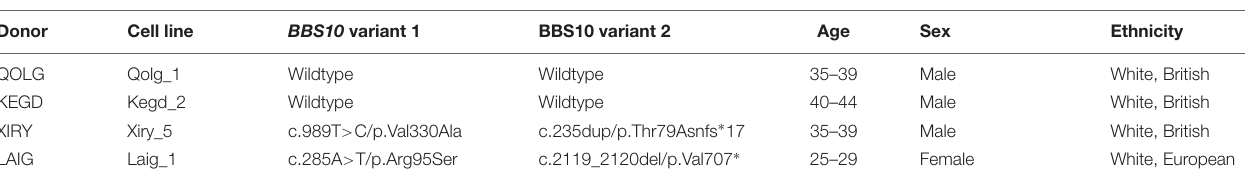
FIGURE 1 | BBS10 variant hiPSCs are pluripotent and can form cilia. (A) Schematic representation of the primary cilium. AX, axoneme; BB, basal body; IFT, intraflagellar transport. BBS1-20 proteins are depicted in their associated complex (BBSome and chaperonin) or by localization to other structures (scheme adapted from Suspitsin and Imyanitov, 2016). (B) Schematics showing BBS10 transcript and protein structure (723AA). Regions exhibiting homology with chaperonin domains are shown in the wildtype protein (scheme adapted from Álvarez-Satta et al., 2017). Variants from two BBS10 mutant lines XIRY (blue) and LAIG (red) are mapped onto protein domains with comparison to control (QOLG or KEGD). (C–E) Cells were immunostained for the pluripotency marker OCT3/4. Control (QOLG) cells and BBS10 mutants (XIRY and LAIG) all had positive staining in the nucleus. Merge with DNA dye Hoechst (C’–E’) . All cells exhibit staining although there is some variability with less intense staining being seen in the central regions of the colonies. (F–H) Staining for the ciliary axoneme marker, ARL13B was performed. Control (KEGD) cells show positive staining for ARL13B (F) . XIRY cells and LAIG cells (H) both express cilia. Merge with DNA dye Hoechst (F’–H’) . Cilia frequency was quantitated by manual counting (I) . LAIG cells had a moderate increase in percentage of cells with cilia compared to control cells. XIRY cells showed no significant difference although were more variable. P -values were determined using unpaired Student’s t -tests ( ∗ P ≤ 0.05). Scale bars (E’,H’) = 50 µ m.